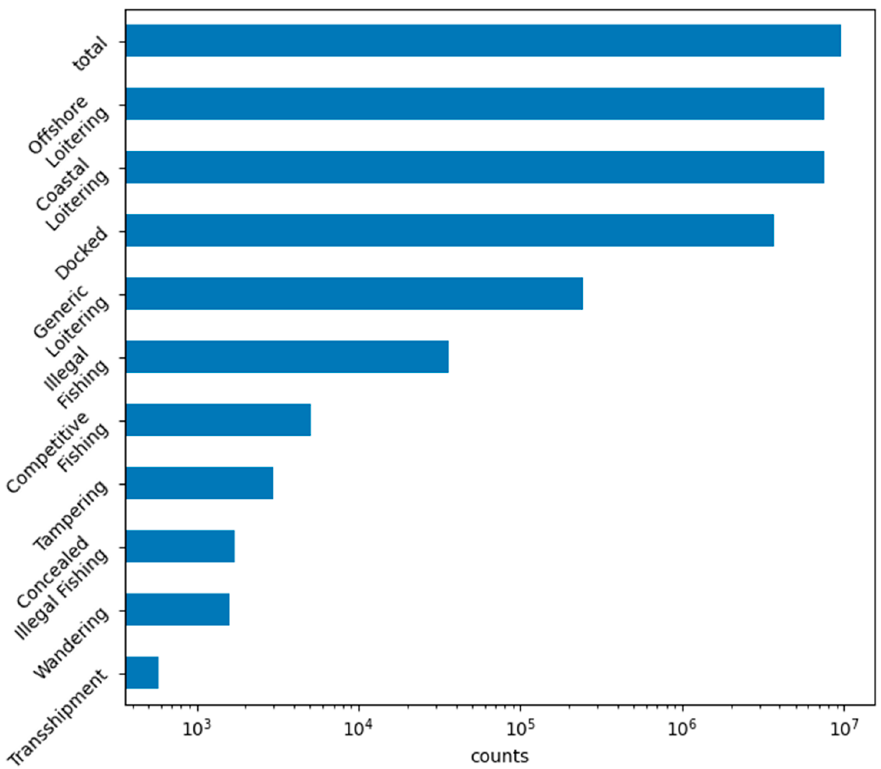
Figure 5. Bar chart showing total counts across the Ship Log that were labeled in the final